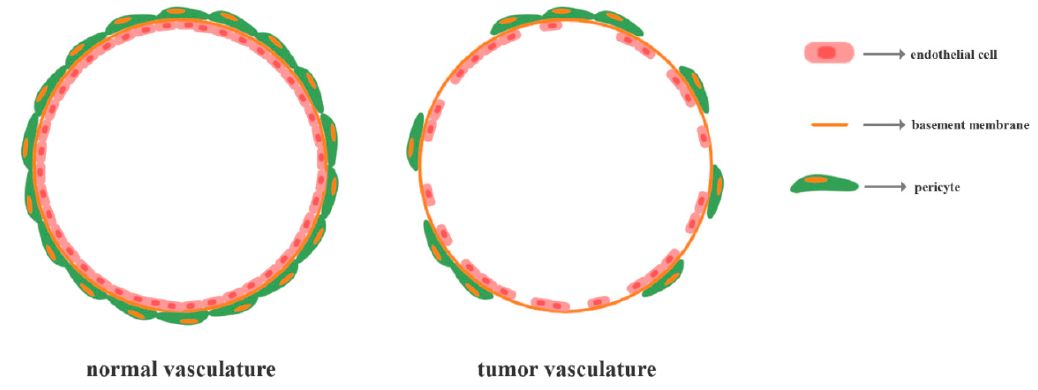
Figure 1. A schematic representation of the normal and tumor vasculature.